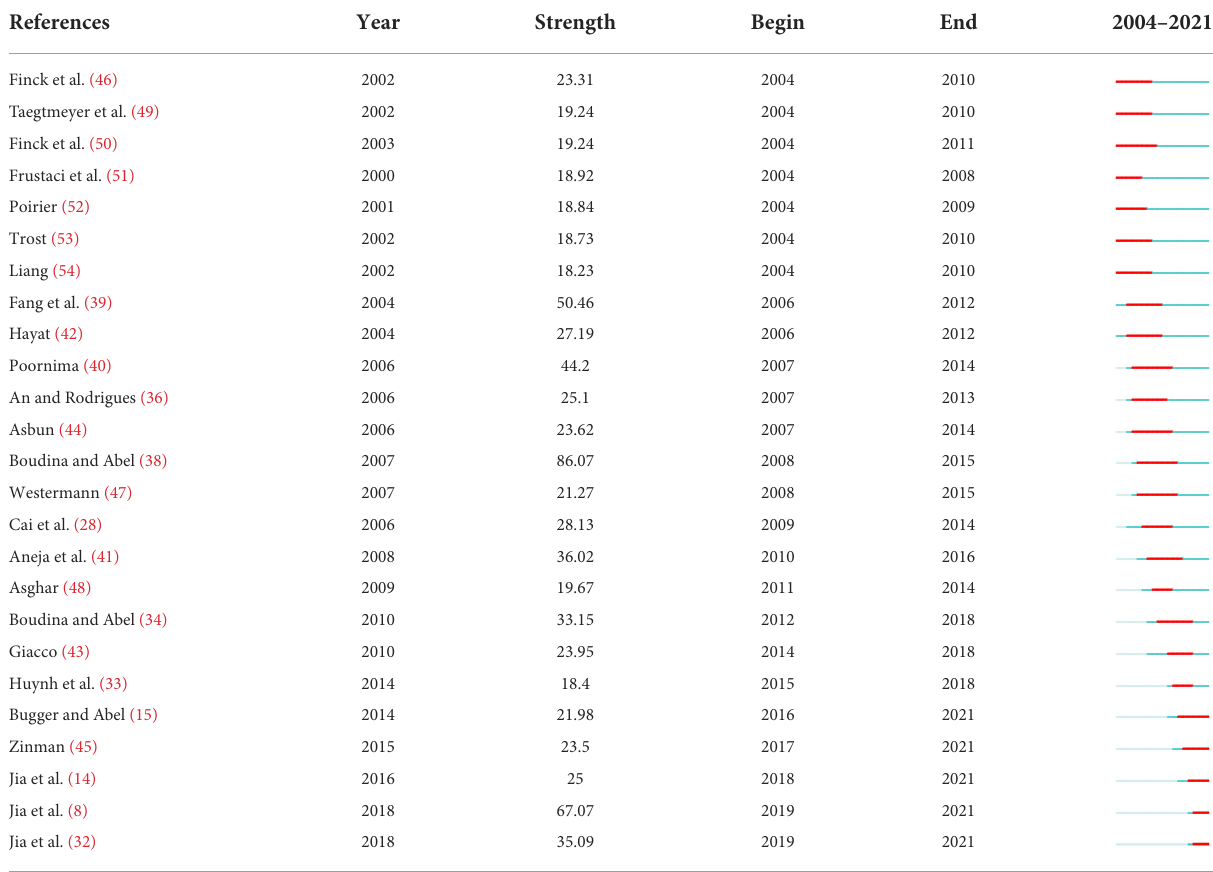
TABLE 5 Representative references sorted by the beginning of the